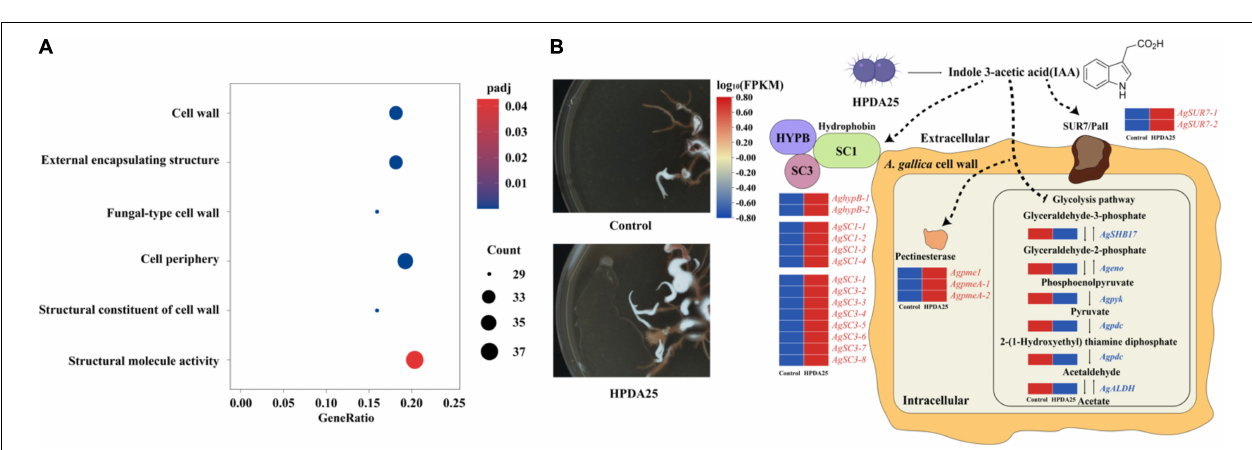
FIGURE 5 | HPDA25 secreted 2.6 indole-3-acetic acid (IAA) and promoted A. gallica growth. (A) IAA was detected by ultra-performance liquid chromatography coupled to a triple quadrupole mass spectrometry. (B) A. gallica cultured in different mediums. (C) IAA increased rhizomorph’s fresh weight, growth rate, branching, and extracellular laccase activity of A. gallica . Control, A. gallica cultured alone in medium. Data are shown as means ± SE. Different letters indicate a significant difference at P < 0.05 level.